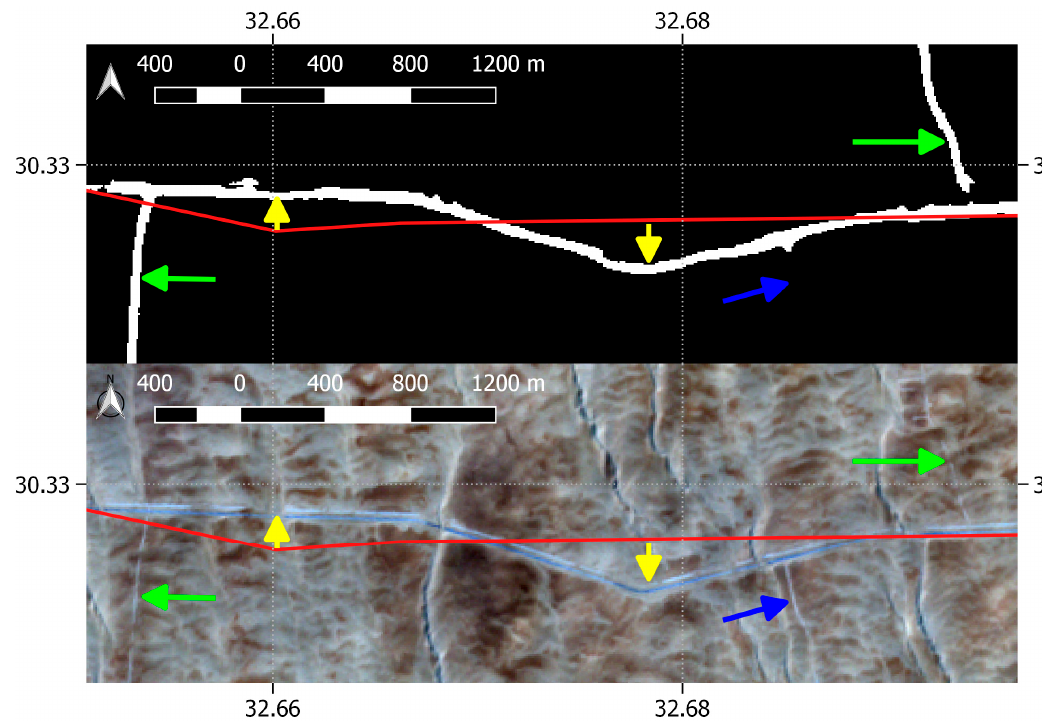
Figure 5. Above: mask of detected roads. Below: Sentinel–2 image. Red line shows the Open Street Map (OSM) road data overlaid. The yellow arrows highlight the misregistration between the OSM road and both detected (mask) and actual (Sentinel–2) roads. Green arrows show roads which are not in the OSM dataset. Blue arrows point to a road which was neither in the OSM data, nor detected by the model. Contains modified Copernicus Sentinel–2 data 2020.